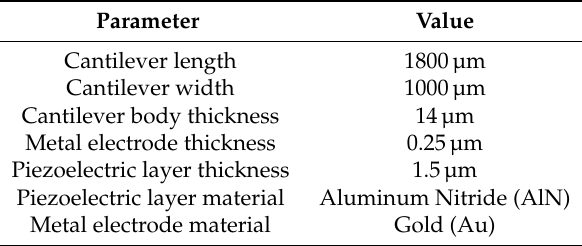
Figure 3. ( a ) Convergence study for the cantilever beam first mode resonance frequency versus the number of partitioning, showing convergence for less than 2 k number of partition. ( b ) Convergence study for the average potential difference in piezoelectric material versus the number of partitioning, showing convergence around 2 k number of partitioning. Table 1. Initial parameters used for simulation of stationary study on piezoelectric effect as well as the effect of width and length on cantilever resonance